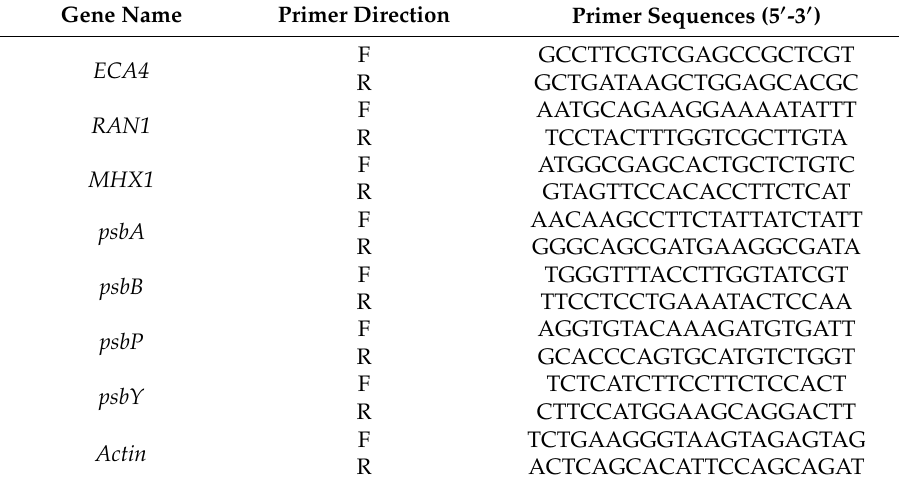
Table 1. Primers of candidate genes in bermudagrass.